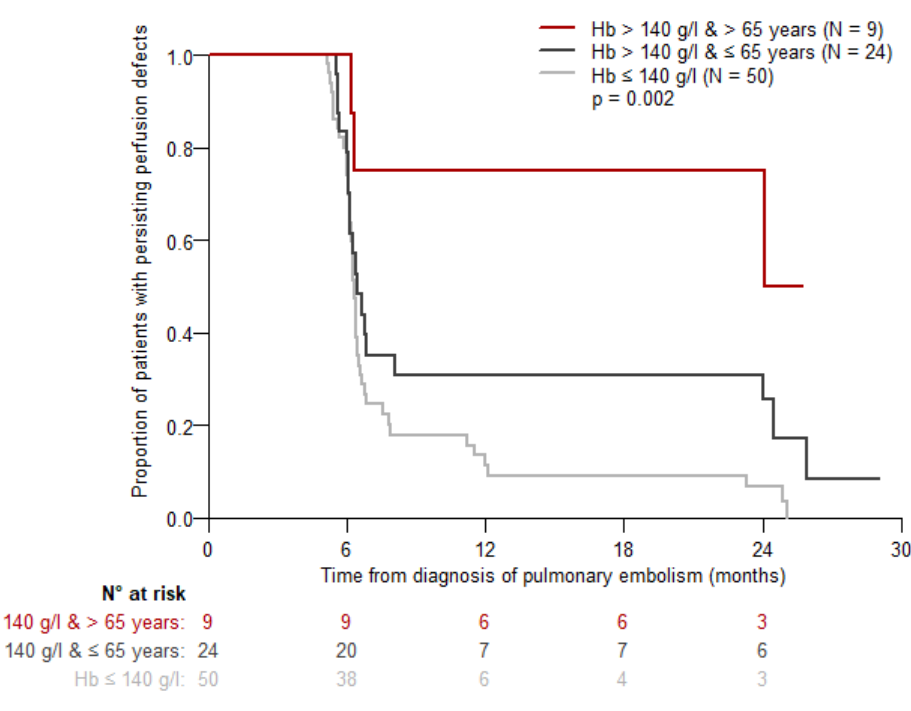
Fig. 1. Kaplan-Meier curves of persisting perfusion defects in the individual risk groups. Reperfusion was considered as an event. The values of the curves correspond with the probabilities of persistence of the perfusion defects after reaching a given time point for individual risk groups. Absolute numbers of patients with persisting perfusion defects at individual time points and risk groups are indicated below the